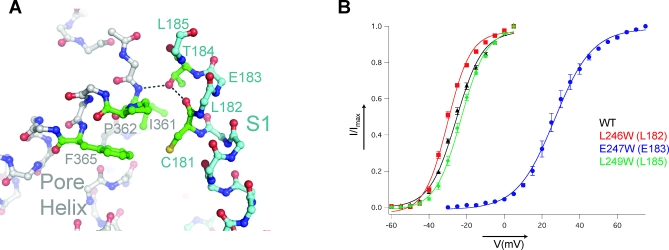
Voltage-Dependent Gating Properties of S1–Pore Interface Tryptophan Mutants(A) Close-up view of the S1–pore interface in the structure of paddle chimera (PDB ID: 2R9R). Pore helices are shown in gray and S1 helices are shown in cyan. Co-evolved residues (green) are shown in ball-and-stick representation. The residues corresponding to the ones mutated in Shaker have been labeled in blue.(B) Shown are mean ionic currents at 5-mV increments, normalized and fitted to a two-state Boltzmann (see Materials and Methods). The corresponding residues in Kv1.2 are given in parentheses.